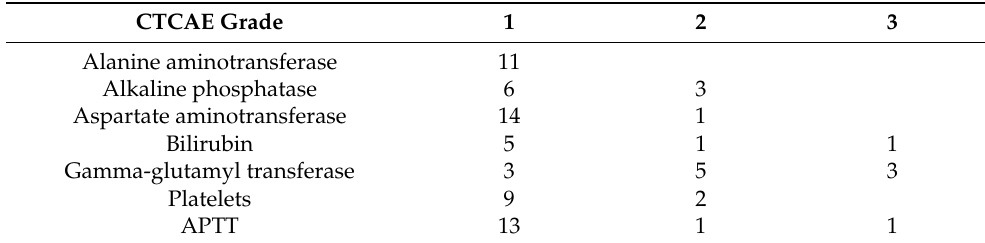
Table 4. Incidence rates of biochemical toxicity between baseline and three months after radioem- bolization according to CTCAE version